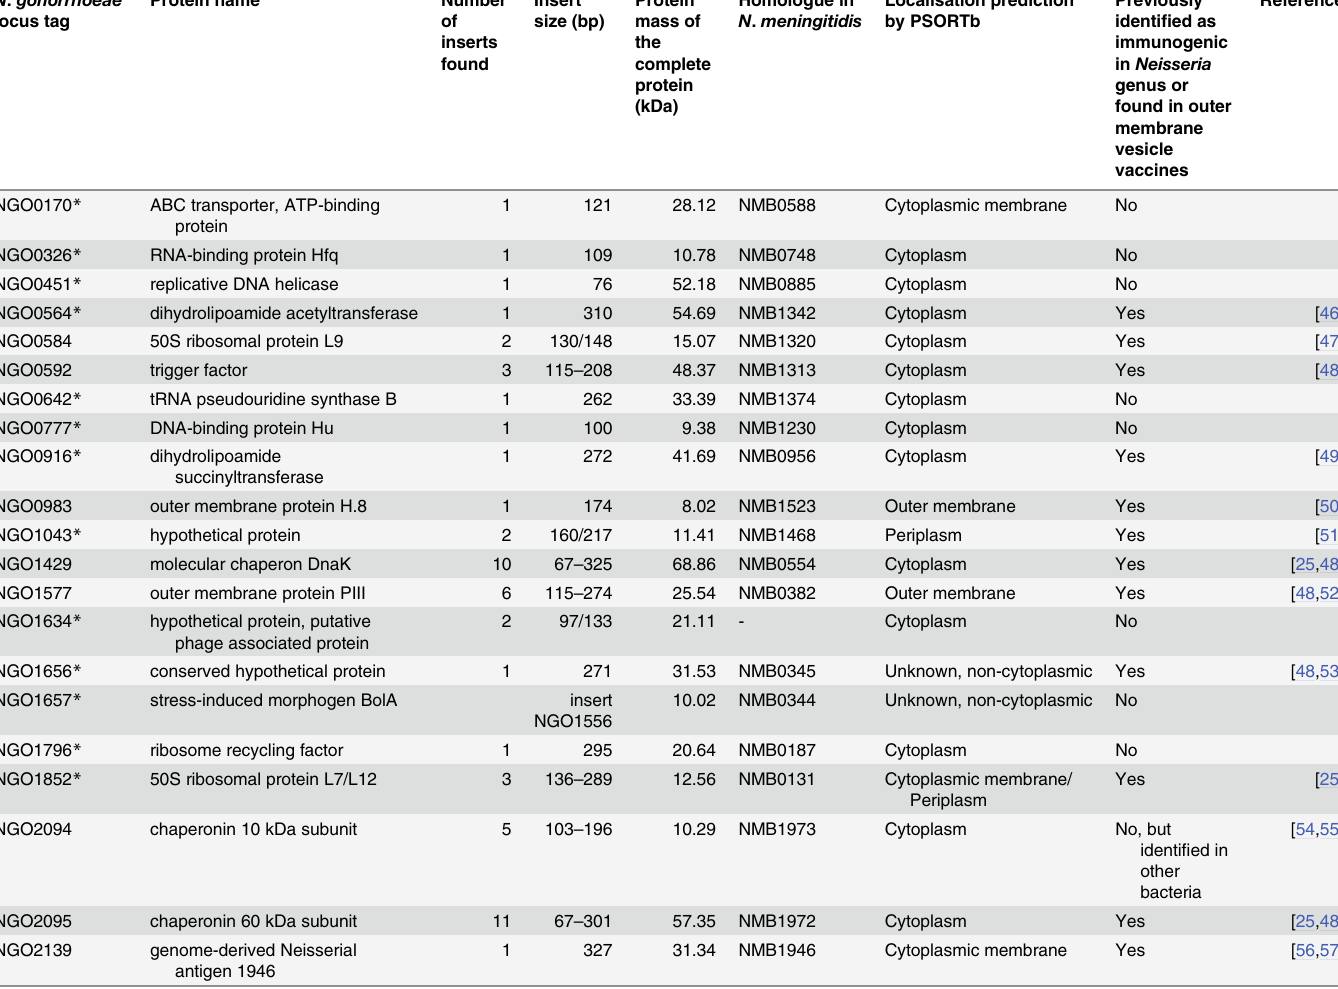
Table 1. Obtained oligopeptides isolated by phage display and corresponding proteins identified by